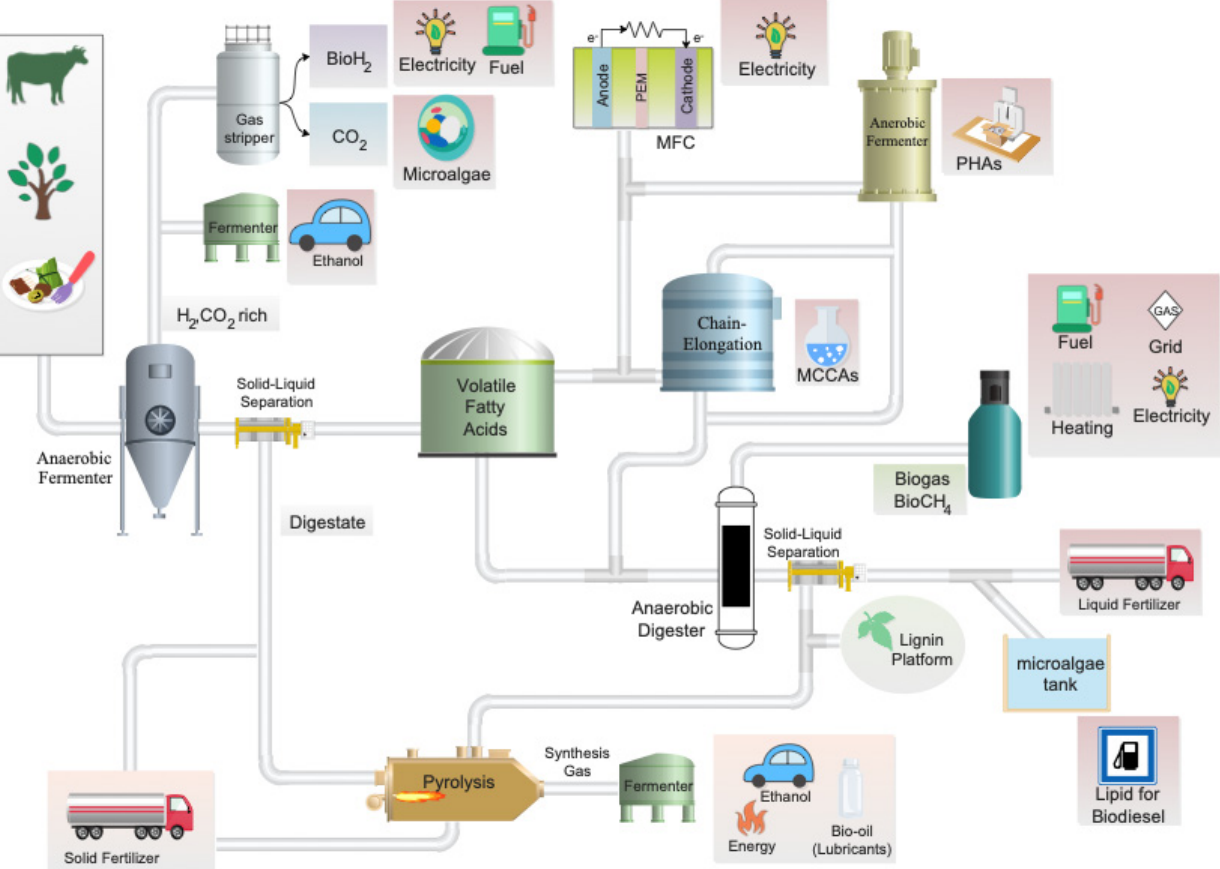
Figure 1. Potential biorefinery process focusing on maximizing VFA production. The process begins with the valorization of residual feedstocks and culminates in the potential production of various high-value end-products (highlighted in pink).